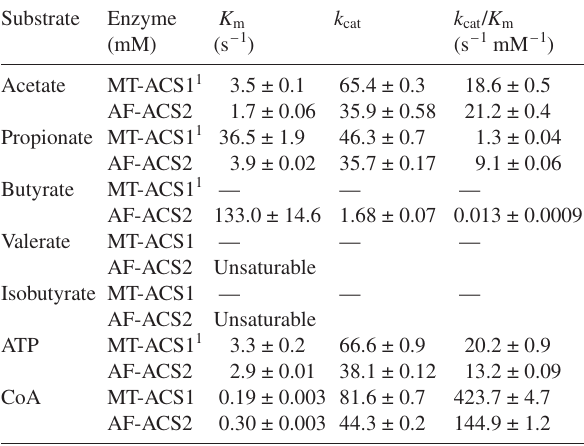
Table 1. Kinetic parameters for MT-ACS1 and AF-ACS2.